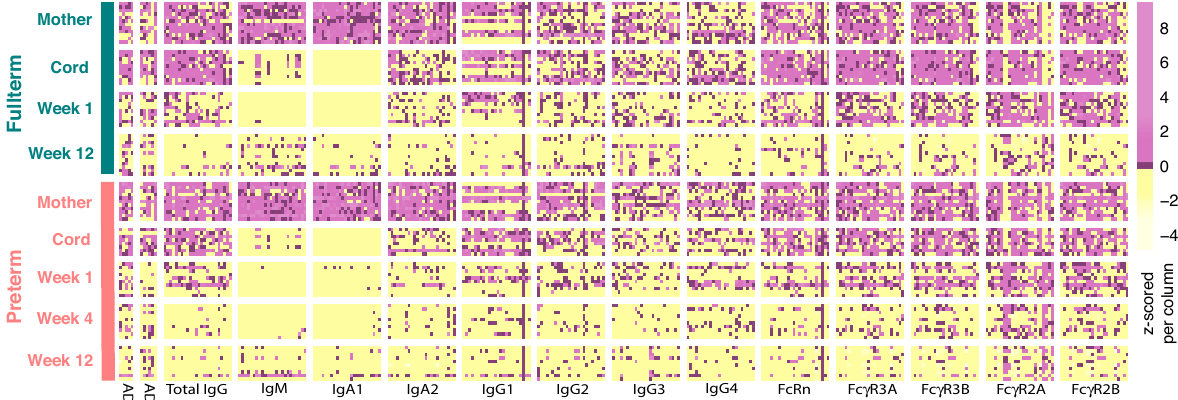
Figure 1. The evolution of the humoral response early in life. The heatmap depicts antigen-specific antibody measurements including antibody-dependent cellular phagocytosis (ADCP, for 5 antigens), antibody-mediated neutrophil phagocytosis (ADNP, for 6 antigens), total IgG, IgM, IgA1-2, IgG1-4, FcRn, FcgR3A, 3B, 2A, and 2B levels across 24 antigens (“Methods”, Table S1). Each column represents an antigen-specific measurement, always plotted in the same order for each Fc-measurement except for ADCP and ADNP, i.e. measles, mumps, rubella, pertussis toxin, influenza, VZV, polio, HepA, pneumo, Adeno T5, Adeno T40, Norovirus, Parvo VP2, tetanus, diphtheria, HSV1, HSV2, CMV, EBV, RSV, Human Histone H3, nArah2, nBosd8, nBetv1. Antigen specificities from left to right for ACDP: RSV, pneumo, pertussis toxin, rubella, influenza. Antigen-specificities for ADNP from left to right: rubella, pertussis toxin, influenza, pneumo, CMV, RSV. Each data type was normalized to have a zero mean and unit variance. Pink, black, and yellow depict high, mean, and low levels,